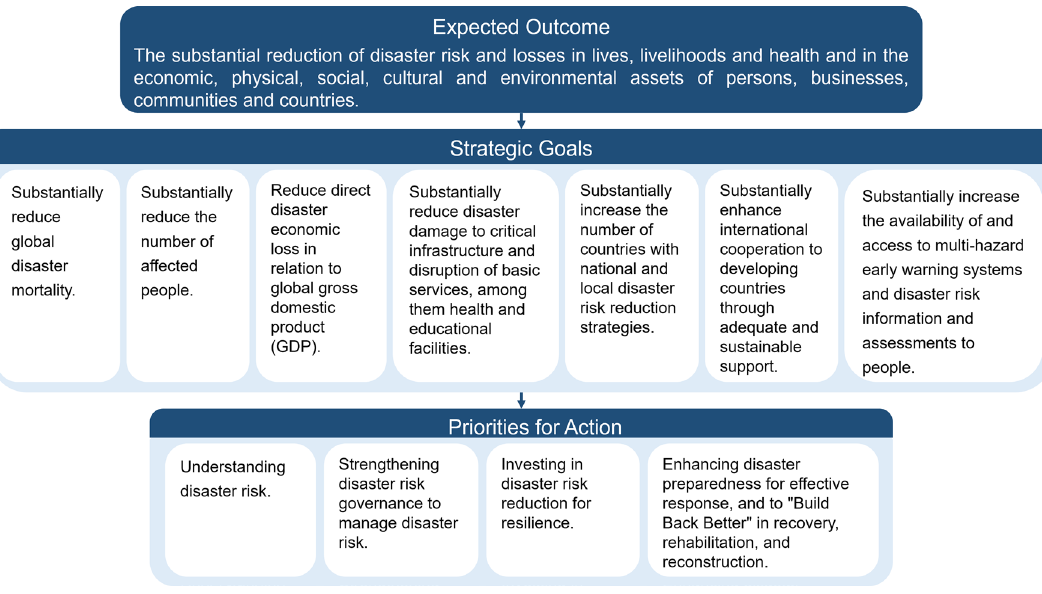
Fig. 3 The Sendai Framework for Disaster Risk Reduction 2015−2030: Expected outcome, strategic goals, and priorities for action (United Nations